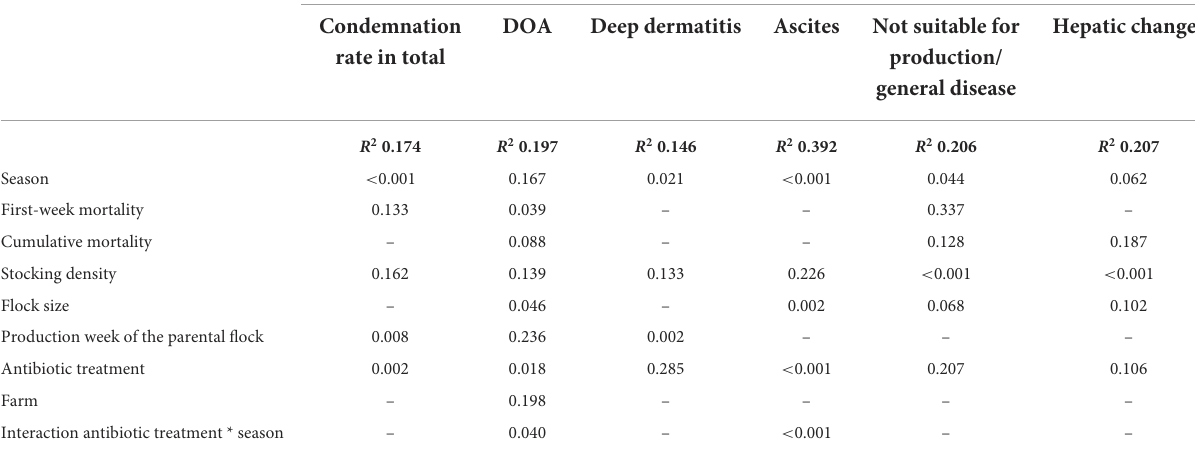
TABLE 4 P -values of the multifactorial analysis using a generalized linear model for the dependent variables condemnation rate in total, dead-on-arrival (DOA), deep dermatitis, ascites, not suitable for production/general disease, and hepatic changes. Independent